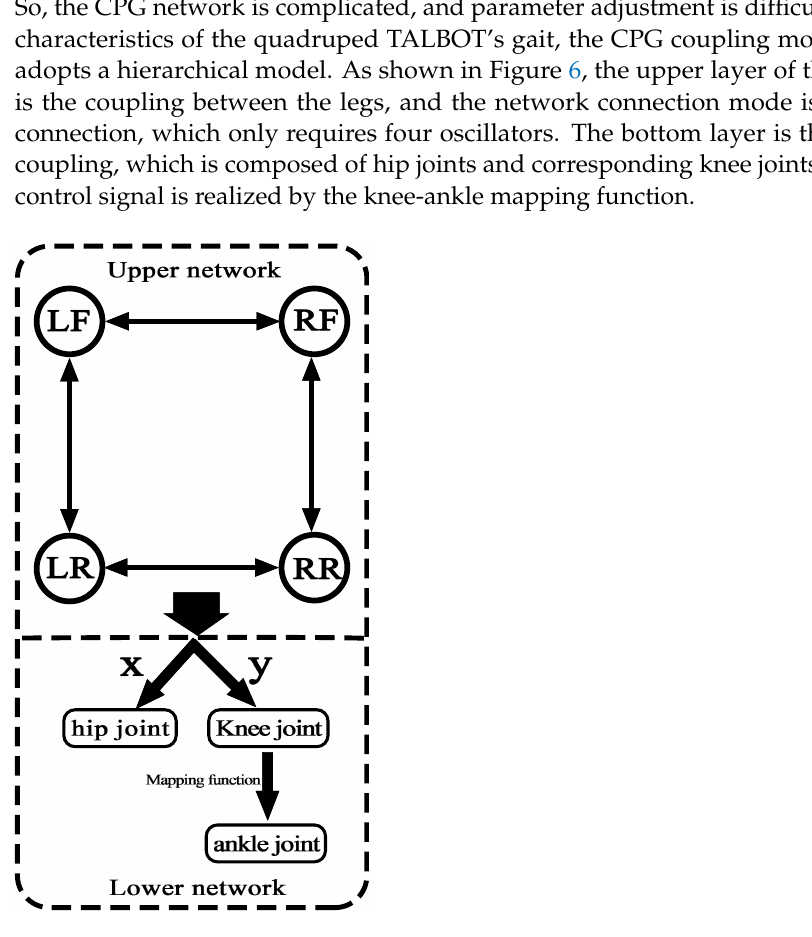
Figure 6. The hierarchical control network of